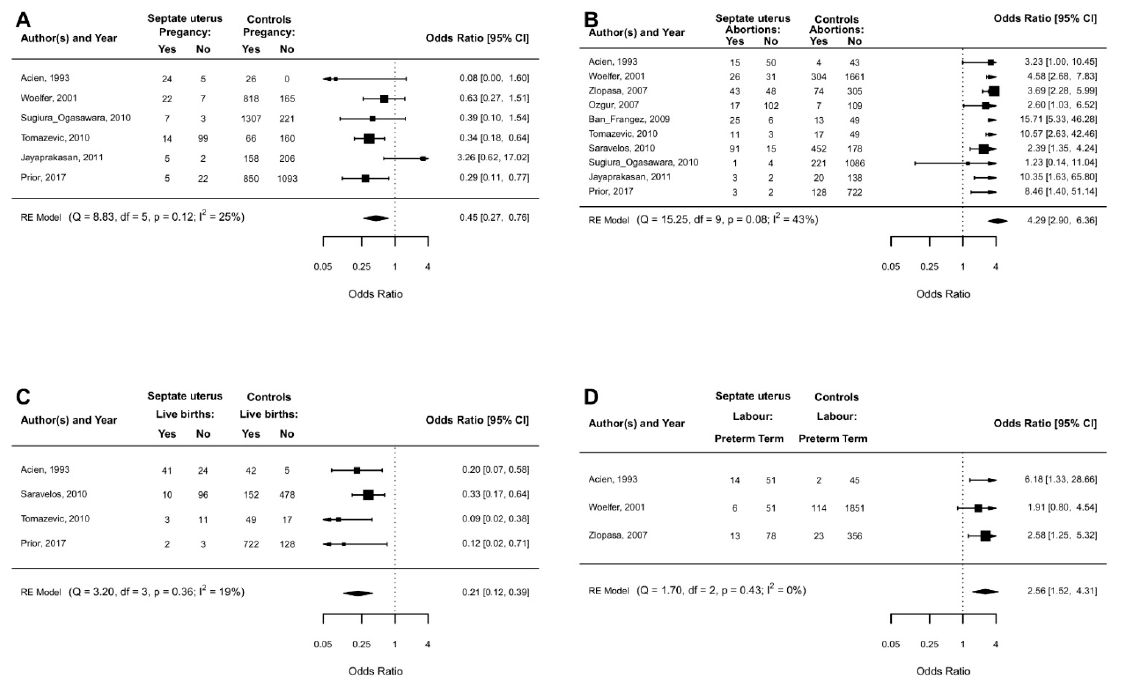
Figure 2. Septate uterus vs. controls (no septate uterus): clinical pregnancy rate ( A ), spontaneous abortions in I-II trimesters ( B ), live birth rate ( C ), and preterm labour ( D ).